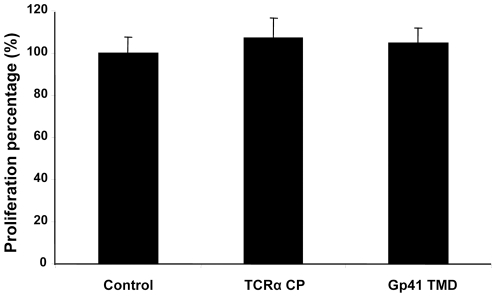
Gp41 TMD does not inhibit T-cell activation induced by PMA/ionomycin.T cells were stimulated with PMA/ionomycin or in the presence of gp41 TMD or TCRα CP, and T cell proliferation was studied. The uninhibited T-cell proliferative responses were 12220±871 cpm. The background proliferation in the absence of antigen was 246±38 cpm. The data are presented as normalized mean proliferation percentage (control, no peptide = 100%)+SD (n = 5 or more). There was no significant statistical difference between all groups.